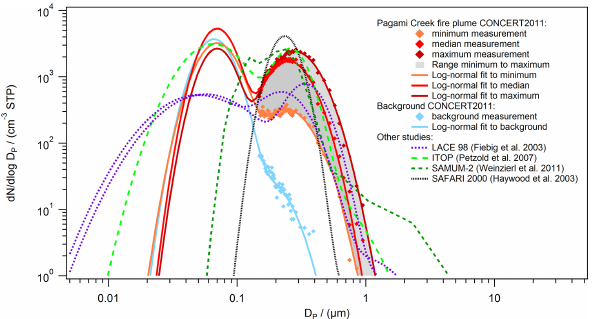
Figure 6. Number size distributions (STP) for background aerosol (blue markers), minimum (orange markers), median (red markers), maximum (dark red markers), and range (light grey area) of mea- surements in the Pagami Creek fire plume. Number size distribu- tions are extrapolated by log-normal fits for the minimum, median, maximum, and background measurements (orange, red, dark red, and blue solid lines), and compared to forest-fire plumes (dashed lines) from LACE 98 (purple) as ambient values, ICARTT ITOP (International Consortium for Atmospheric Research on Trans- port and Transformation, Intercontinental Transport of Pollution; light green), SAMUM-2 (Saharan Mineral Dust Experiment; dark green), and SAFARI 2000 (Southern African Regional Science Ini- tiative; black). Normalized values from SAFARI 2000, showing only the accumulation mode due to a lack of measurements for par- ticle sizes <100nm, are scaled to similar